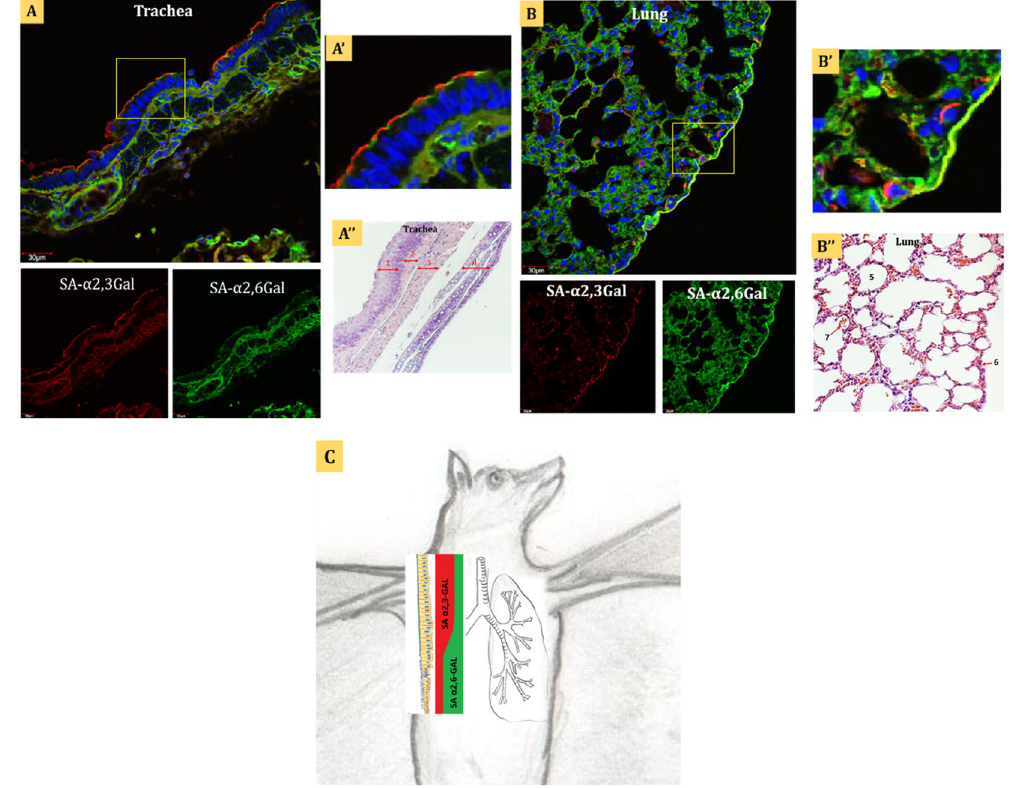
Figure 1. Co-expression of SA α 2,3-Gal and SA α 2,6-Gal receptors in little brown bat respiratory tract. Composite confocal images show co-expression of both SA α 2,3-Gal (red) and SA α 2,6-Gal (green) influenza receptors on the ( A ) trachea and ( B ) lung of the little brown bat (LBB). The SA α 2,3-Gal receptor is the predominant receptor type on the (A’) respiratory mucosal epithelium of the trachea, while the SA α 2,6-Gal receptor type is predominant in the lamina propria and submucosa of the trachea and lungs. ( C ) Schematic representation of the SA receptor distribution in the respiratory system of LBB shows predominance of SA α 2,3- Gal receptor type in the upper respiratory tract, which gradually decreases towards the lower respiratory tract. In contrast, SA α 2,6-Gal receptors gradually increases towards the lower respiratory tract. Tissue sections were stained with biotinylated MAAII (red - specific for avian type receptor, SA α 2,3-Gal) and FITC labelled SNA (green - specific for human type receptor, SA α 2,6-Gal) lectins, and DAPI nuclear stain (blue). A”: haematoxylin and eosin (H and E) stained tracheal tissue section. 1. respiratory epithelium, 2. lamina propria, 3. submucosa, 4. hyaline cartilage B”: H and E stained lung tissue section. 5. alveolar duct, 6. visceral pleura, 7. pulmonary blood